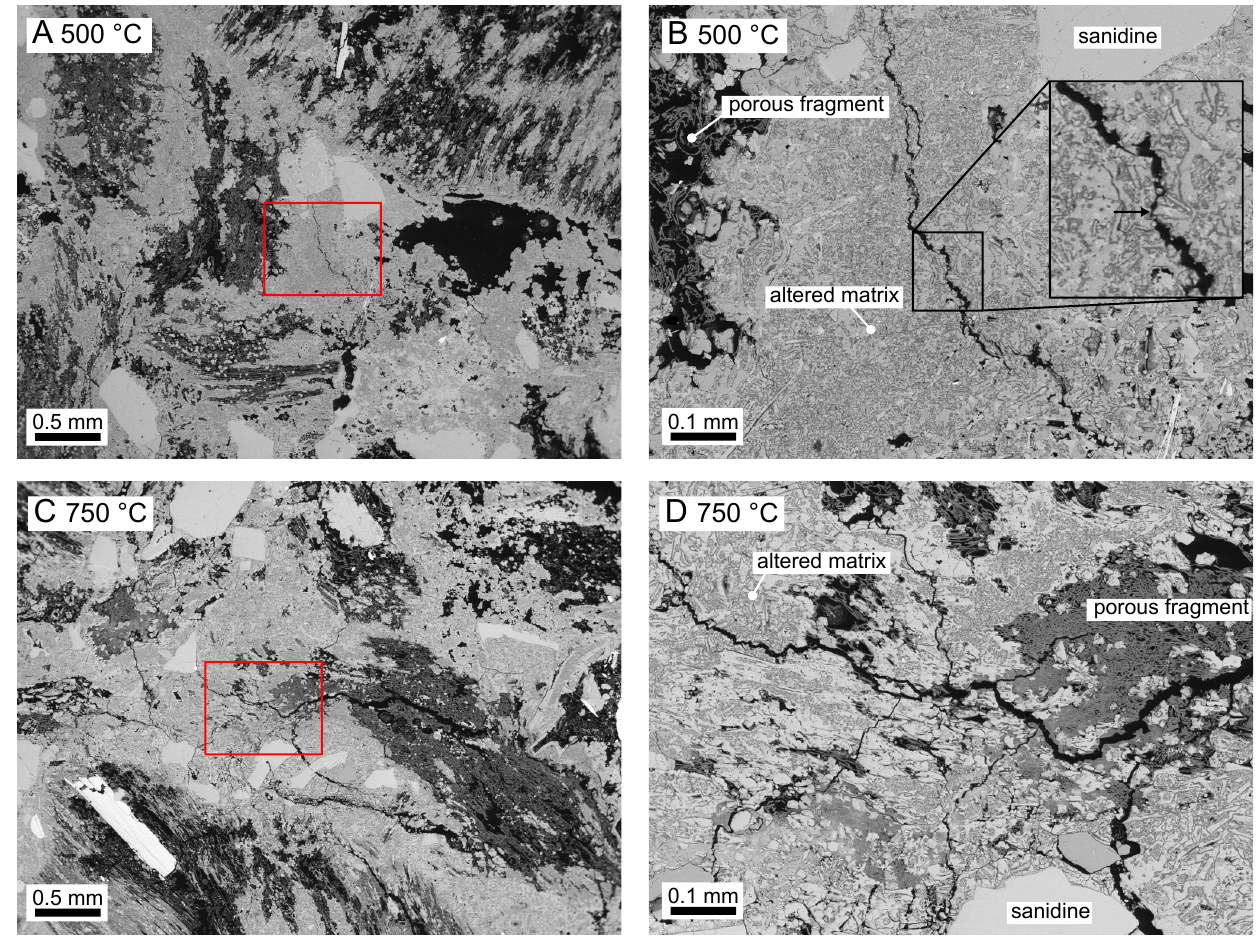
Figure 10: Backscattered scanning electron microscope images of Mt. Epomeo Green Tu ff (MEGT) that have been thermally stressed to 500 ◦ C (panel [A]) and 750 ◦ C (panel [D]). Panels [B] and [D] show zoomed-in images from panels [A] and [B], respectively (indicated by the red rectangles). Inset in panel [B] shows a close-up of the fracture; the arrow indicates a crystal fragment that has deflected the path of the tortuous